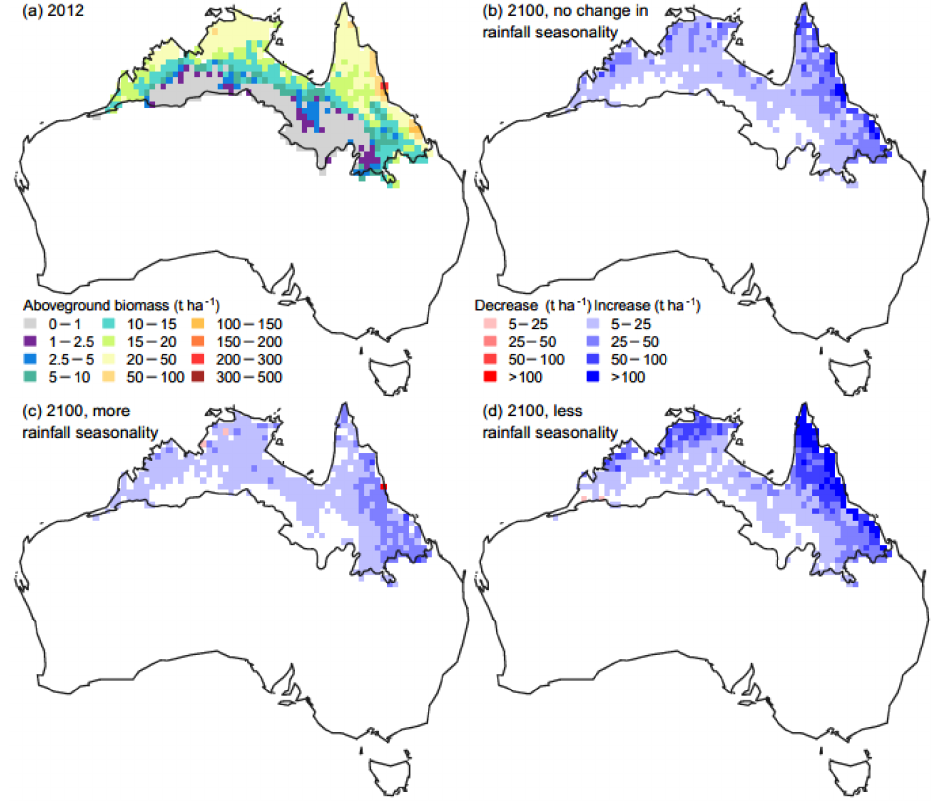
Figure 2. Predicted changes to aboveground biomass over the period of 2012 to 2100 for the Australian savanna region following three scenarios of projected rainfall seasonality according to IPCC SRES A1B (IPCC, 2007). The simulations were conducted using an adaptive dynamic global vegetation model (aDGVM) and predicts how (a) present-day (2012) aboveground biomass changes, when (b) rainfall seasonality does not change, (c) rainfall seasonality increases and (d) rainfall seasonality decreases over the forecast period. In all cases, the aboveground biomass of the Australian savanna region increases, with the magnitude of change determined by the degree of seasonality. Reprinted with permission from Scheiter et al.